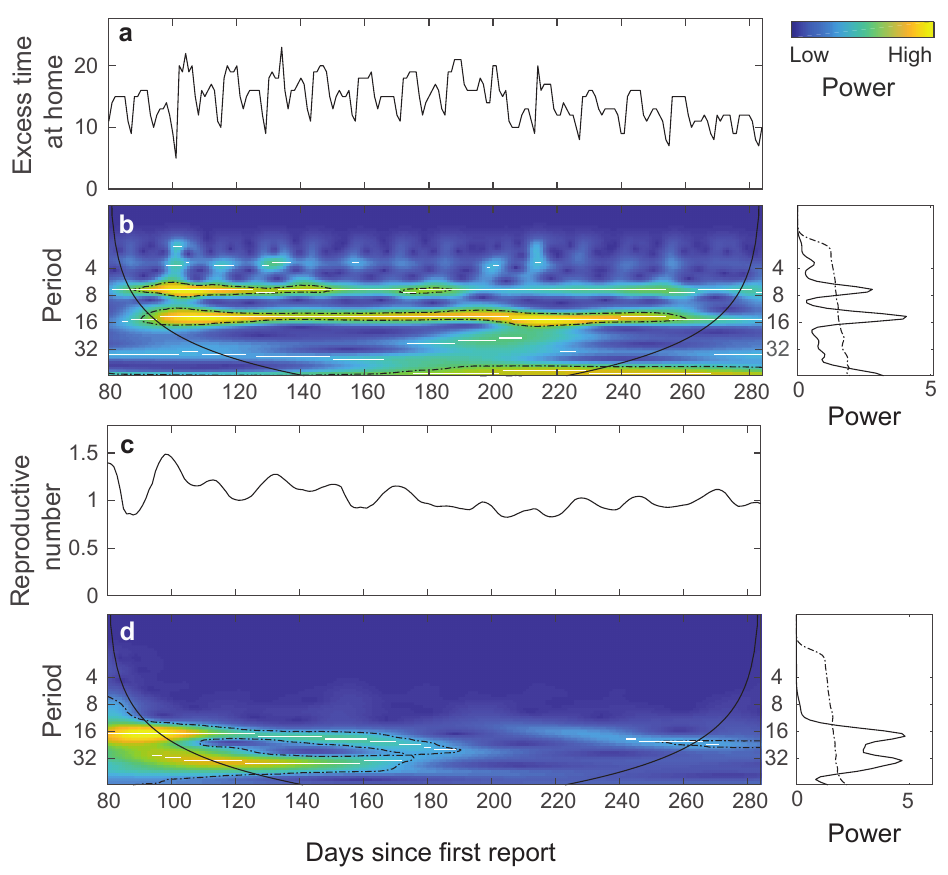
Figure 4. Time series and wavelet power spectra of the residence time ( a , b ) and the effective reproduction number ( c , d ) between mid-June and mid-December 2020. The colors for power values range from dark blue (low values) to orange (high values). Strong signals with periods of 7 and 15 days are observed in the excess residence time ( b ). A weak and interrupted signal with a period of 15 days is shown for the effective reproductive number ( d ). The black lines correspond to the maxima of the undulations of the wavelet power spectrum. Right: the two global spectra corresponding to each